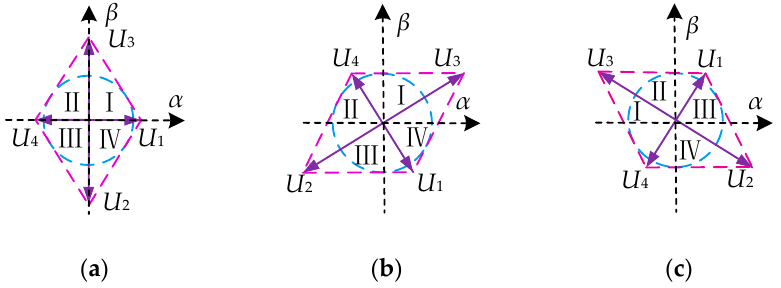
Figure 2. Voltage space vectors. ( a ) Phase a leg fault; ( b ) Phase b leg fault; ( c ) Phase c leg fault.